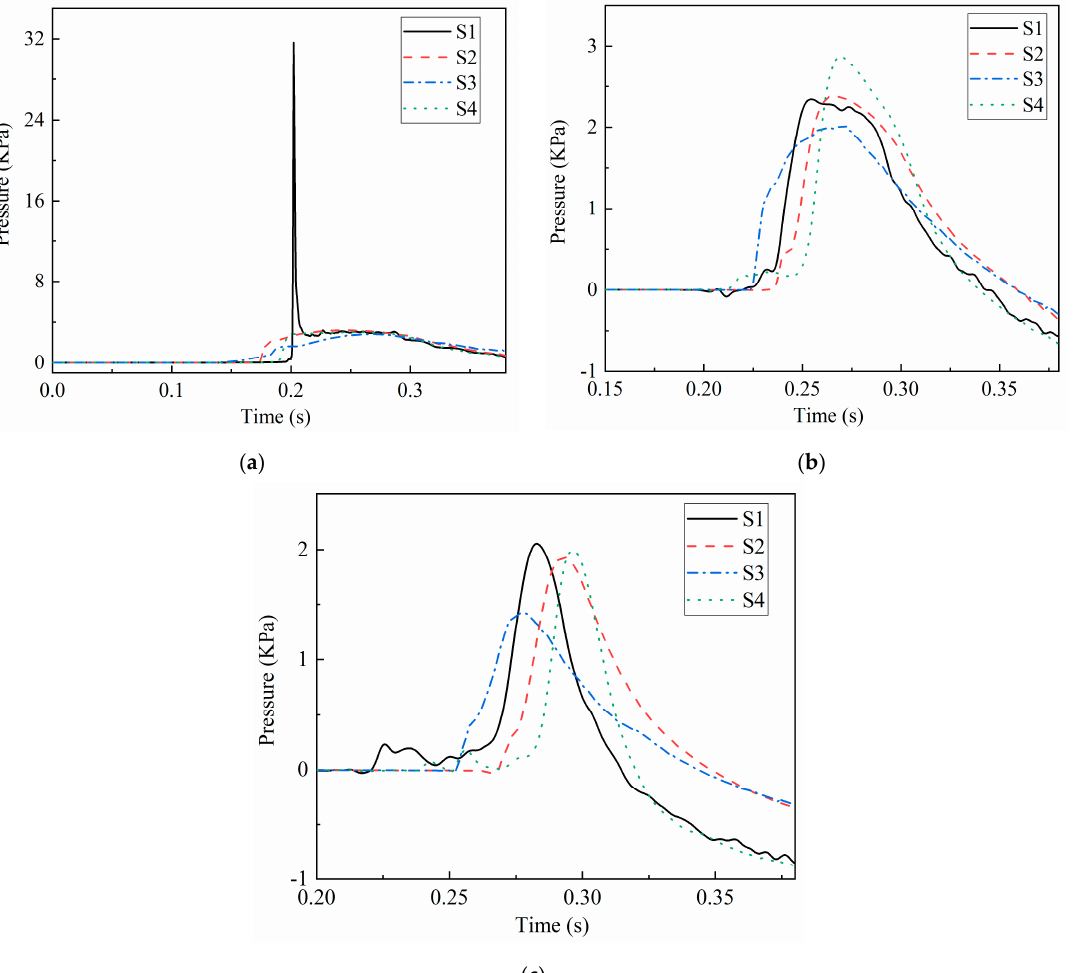
Figure 20. History of the impact pressure of different position: ( a ) P1; ( b ) P2; ( c ) P3.